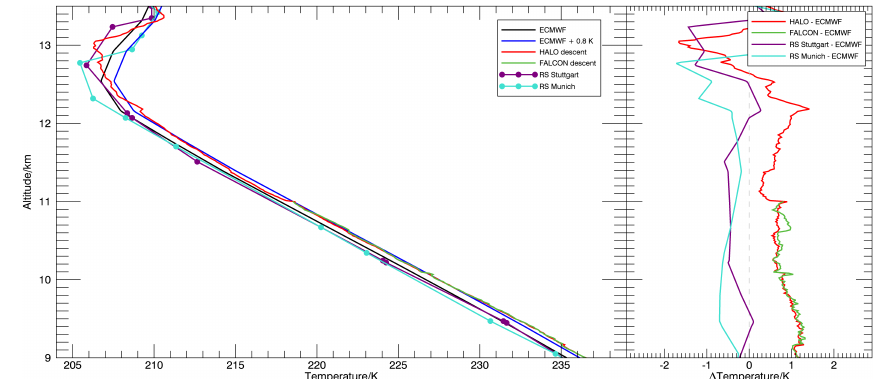
Figure 6. (a) Temperature measurements from radiosondes over Munich (light blue line) and Stuttgart (purple line) at 12:00UTC, 4 Novem- ber 2010, ECMWF model analysis (black line) and in situ measurements from HALO (red line) and Falcon (green line) descents. (b) Dif- ference of ECMWF model analysis temperature data and HALO in situ temperature measurements (red line), Falcon in situ measurements (green line) during descents, and radiosonde temperature measurements over Munich (light blue line) and Stuttgart (purple line).